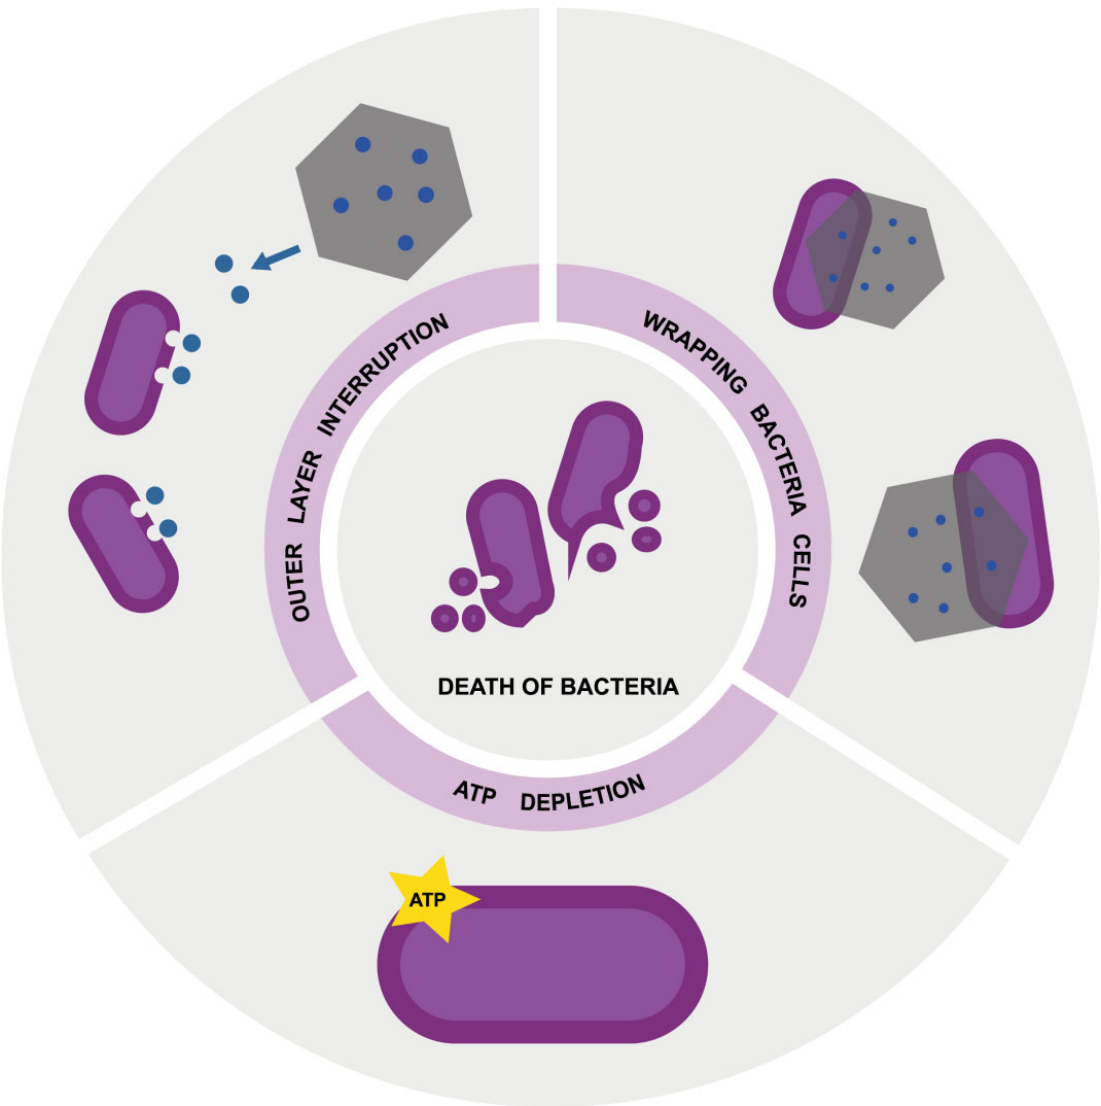
Figure 11. Mechanism of action of nanocomposites, which act on outer layer interruption, wrapping bacteria cells, and ATP depletion, causing cell death.